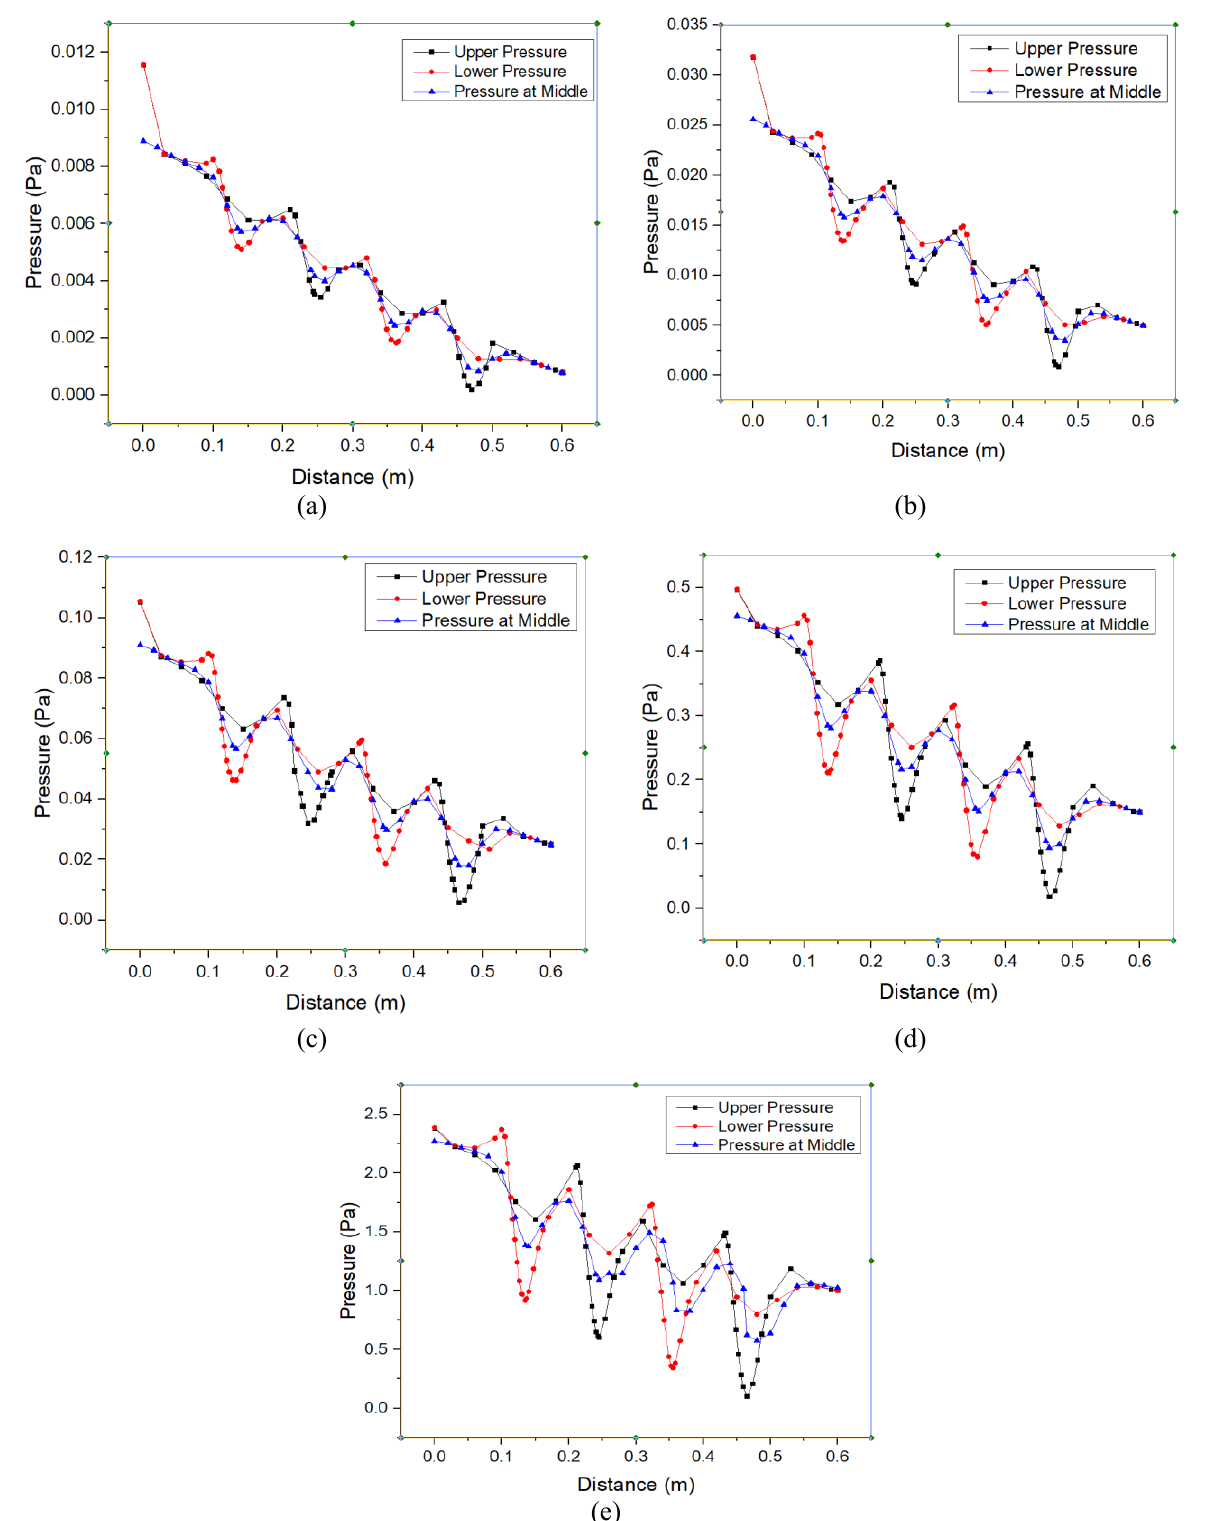
Fig. 9. Effect of fluid flow on velocity Multi-restriction (a) Re=100 (b) Re=200 (c) Re=400 (d)